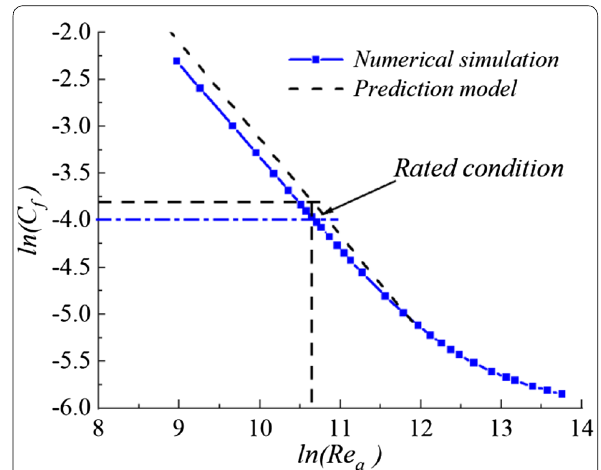
Figure 13 Prediction of the axial flow resistance in the canned part of the